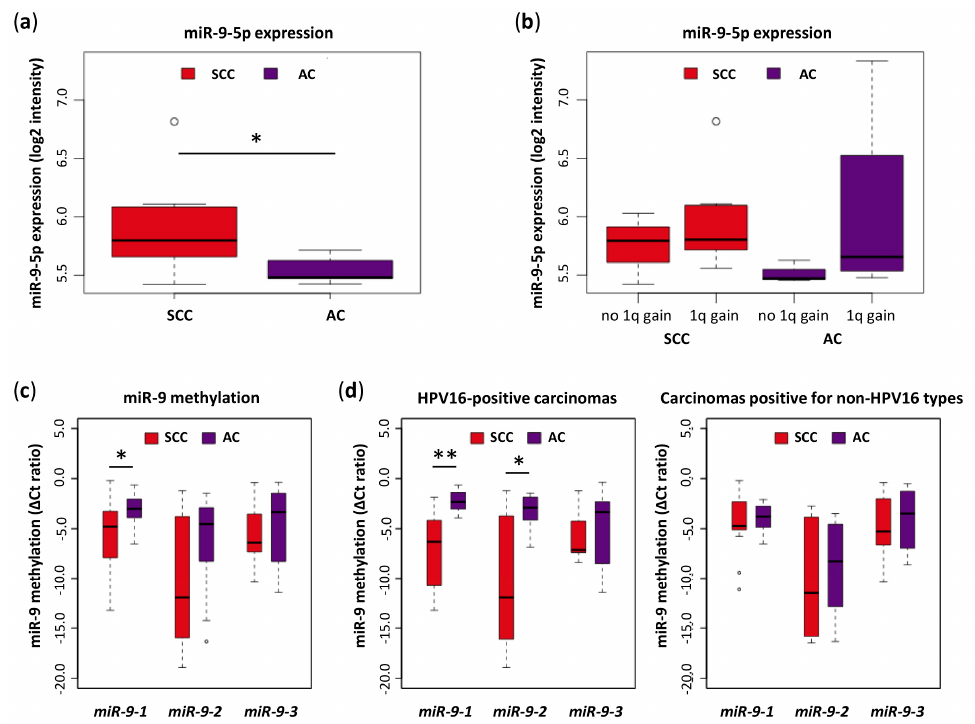
Figure 1. Expression of miR-9-5p and methylation of miR-9 precursors in cervical tissue samples. ( a